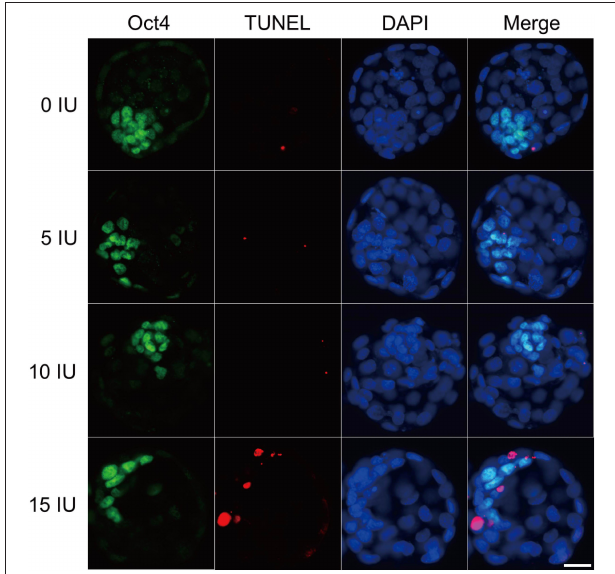
FIGURE 5 | Effects of different eCG doses on apoptosis and cell allocation in IVF-derived mouse blastocysts. Representative fluorescence micrographs of IVF-derived blastocysts obtained from groups primed with different doses of eCG are shown. The proportion of ICM cells was inferred by counting Oct4-positive (green) cells. The percentage of apoptotic nuclei was examined by detecting TUNEL-positive (red) cells. DAPI staining (blue) was used to analyze the total number of nuclei and thus estimate the total cell count of individual blastocysts. Scale bar = 20 µ m.